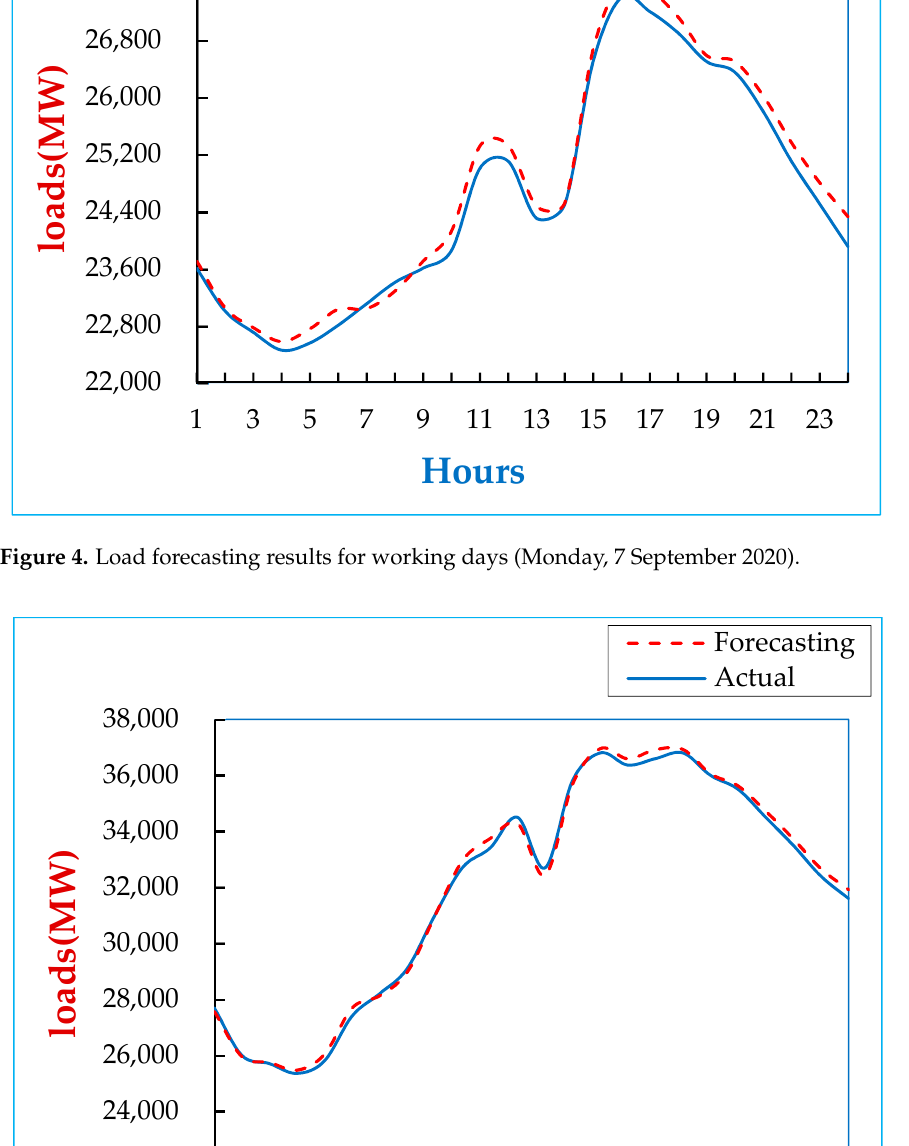
Figure 6. Load forecasting results for a week-long holiday (Saturday, 17 October 2020).